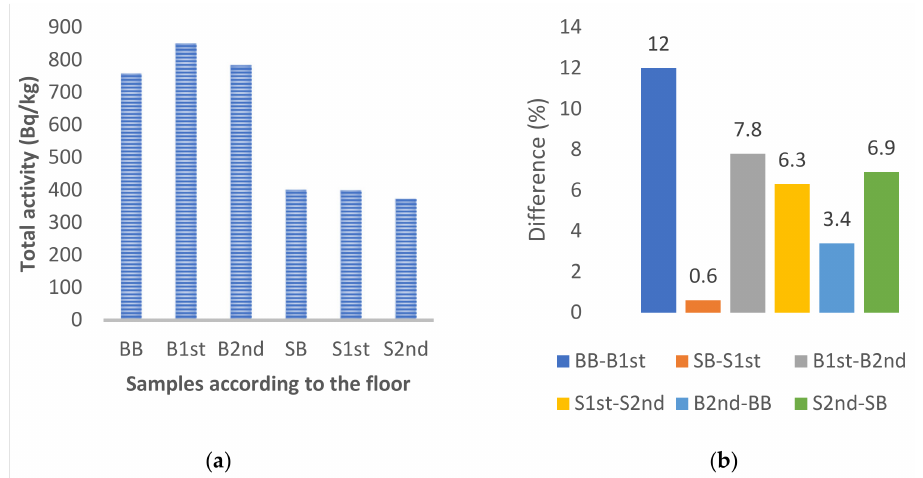
Figure 8. Comparison of the effect of the sample’s floor to total activity of radionuclides ( a ); the differences in total activities of radionuclides in samples collected from different floors ( b